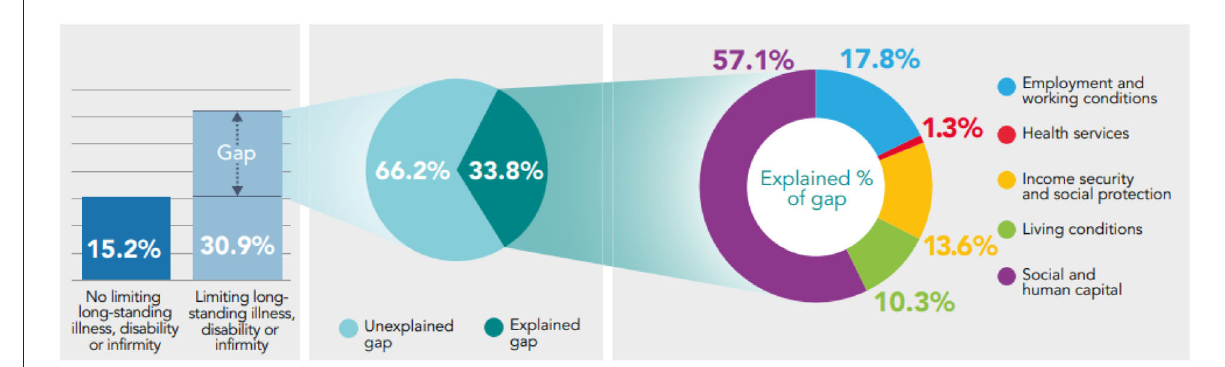
FIGURE7 Decomposing the gap in prevalence of low mental well-being between those reporting a limiting long-standing illness, disability or infirmity, and those who do not using the Binder-Oaxaca methodology, persons aged 16 + , Wales, 2016–17 to 2019–20.